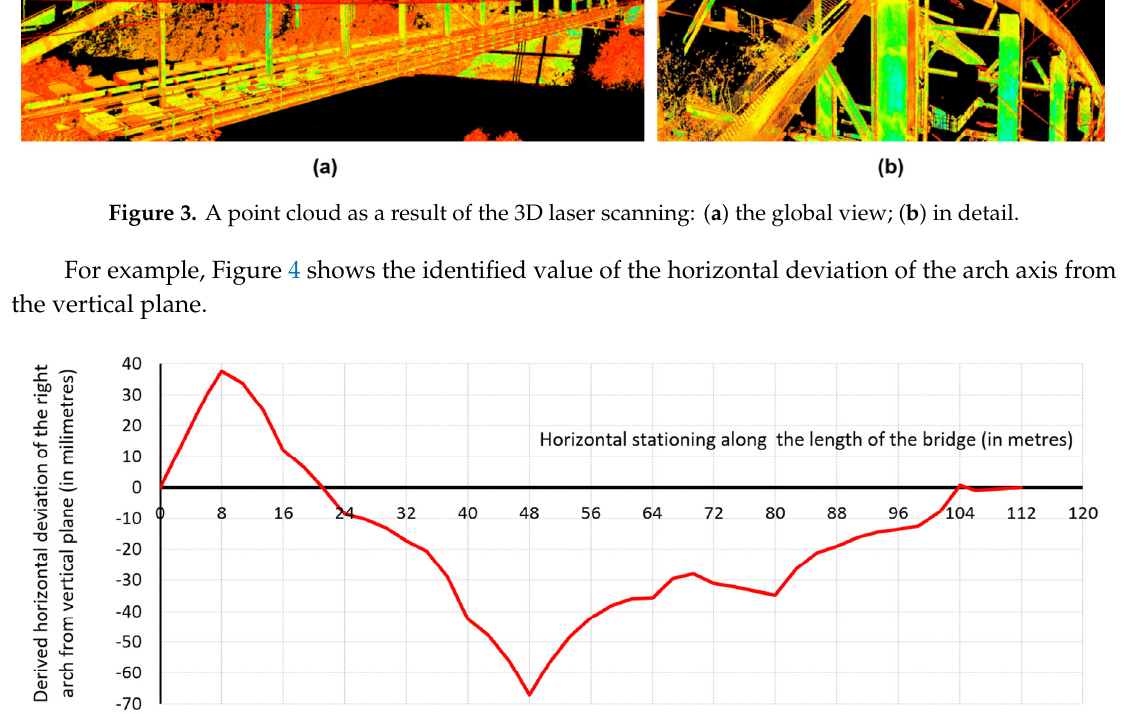
Figure 4. Derived horizontal deviation of the right arch from the vertical plane.